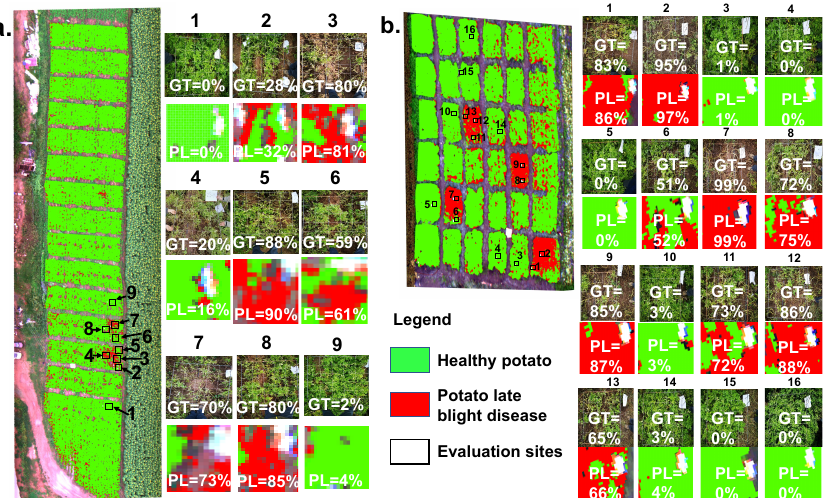
Figure 6. The patch-scale test for the classification maps of healthy potato and potato late blight disease in ( a ) experimental site 1 and ( b ) experimental site 2. Here, the example patches on the right side illustrate the accuracy comparison between the ground truth (GT) investigations and the predicted levels (PL) of the late blight disease. Each value inside the patch represents the disease ratio (the late blight disease pixels/the total